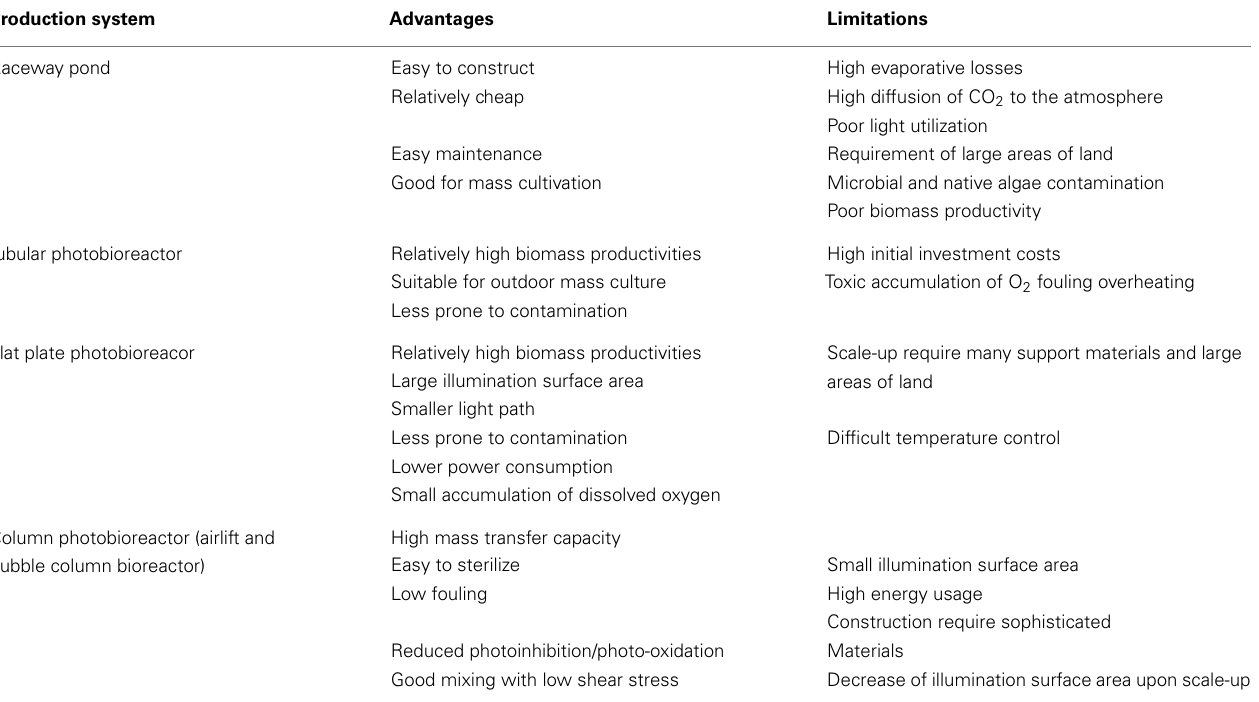
Table 3 |Advantages and limitations of open ponds and PBRs (Singh et al., 2011c; Pires et al., 2012;Arbib et al., 2013)